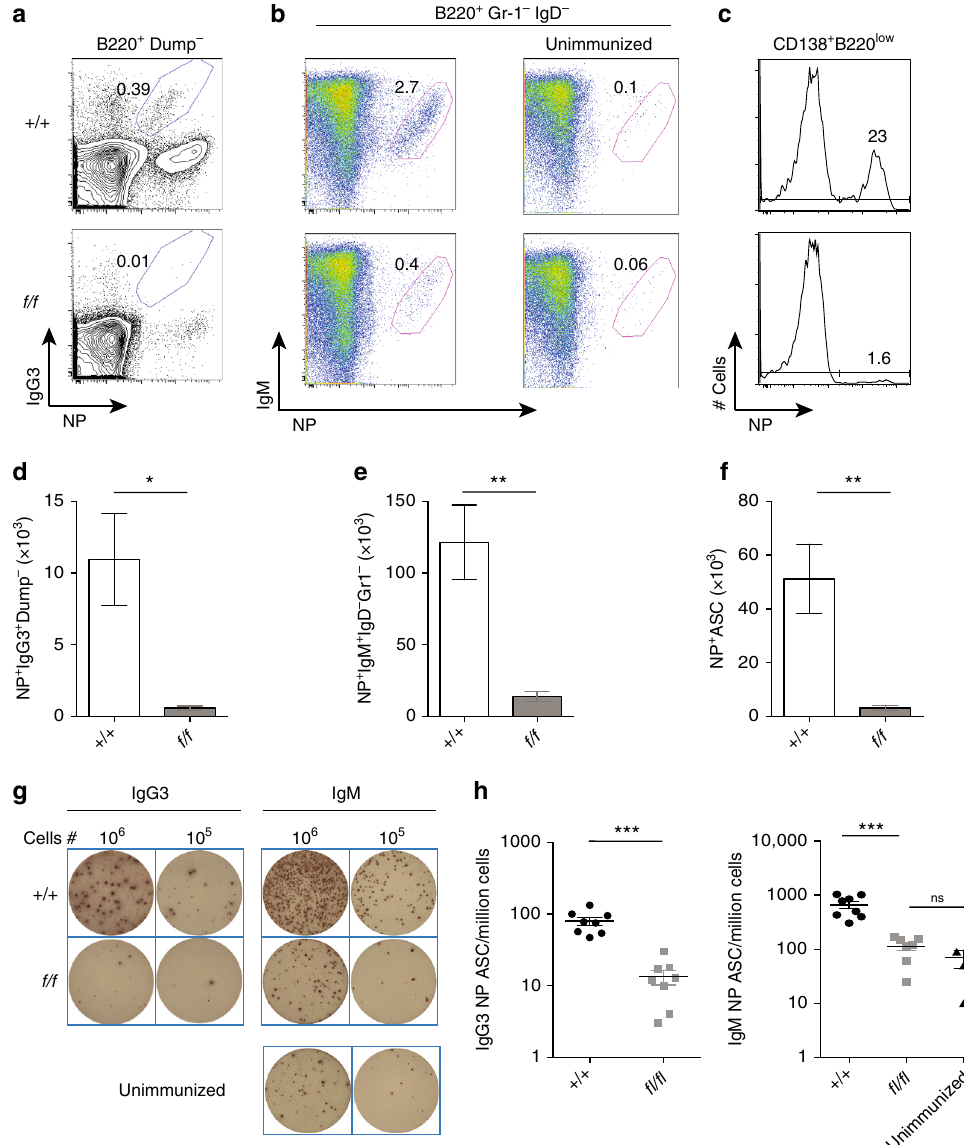
Fig. 5 PRMT1 is critical for a TI immune response. Control ( + / + ) and Prmt1 f / f CD23Cre ( f/f ) mice were injected i.p. with NP-Ficoll and analysed after 5 days. Splenic NP-speci fi c a IgG3 + and b IgM + B cells are shown in representative fl ow cytometry plots along with an unimmunized mouse for IgM in (upper) control (+/+) and (lower) Prmt1 f / f CD23Cre ( f/f ) mice. c Histograms display the proportion of spleen ASC (CD138 + B220 low ) that were NP-speci fi c at day 5 post immunization in (upper) control ( + / + ) or (lower) Prmt1 f / f CD23Cre ( f/f ) mice. a – c Numbers represent the frequency of events within